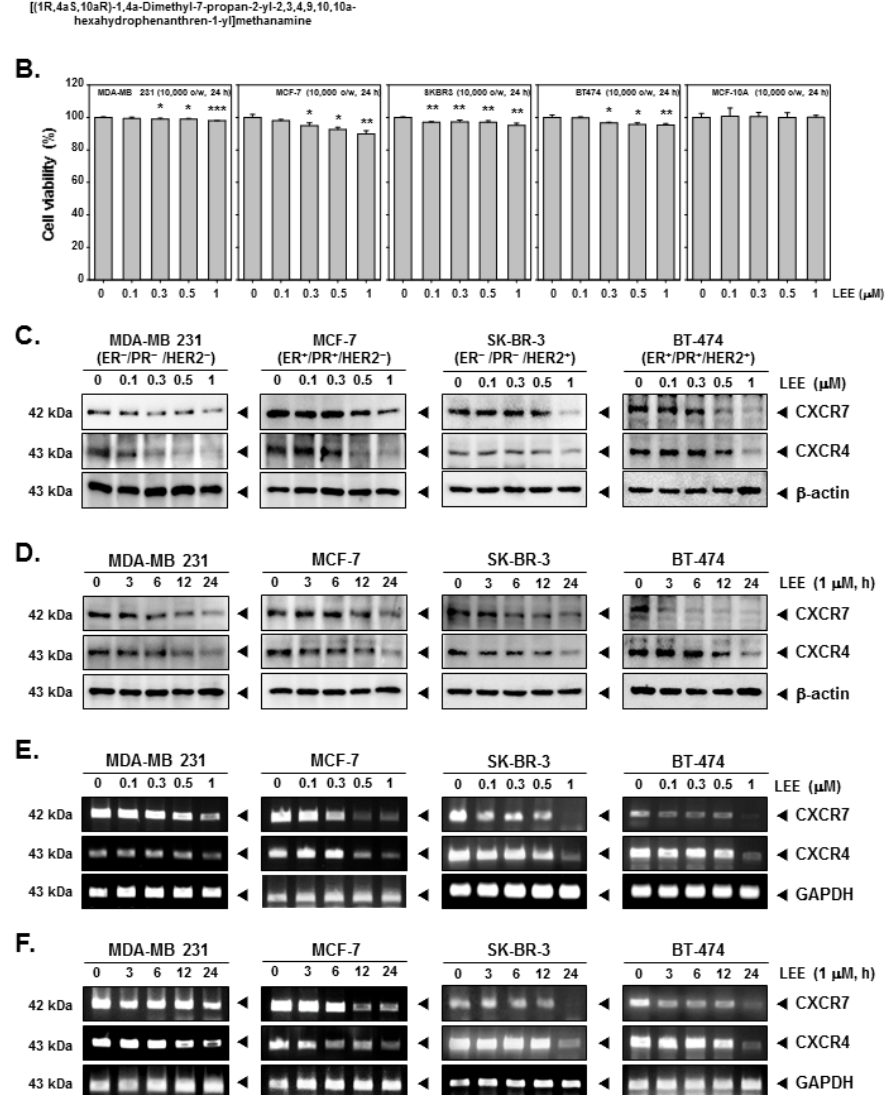
Figure 1. Effects of LEE on inhibition of CXCR7 and CXCR4 in human breast cancer cells. ( A ) The chemical structure of LEE. ( B ) Human breast cancer MDA-MB231, MCF-7, SK-BR-3, and BT-474 cells were treated by LEE with indicated concentrations for 24 h. Then the cell viability was measured by MTT assay. ( C , D ) The cells were treated with LEE at indicated concentrations and for indicated time periods. The protein expression levels of CXCR7/4 were analyzed by Western blot analysis. ( E , F ) mRNA levels of LEE-treated breast cancer cells were analyzed by RT- PCR. All the experiments were individually repeated at least thrice. *** p < 0.001 vs. non-treated (NT) cells, ** p < 0.01 vs. non-treated (NT) cells, and * p < 0.05 vs. non-treated (NT)